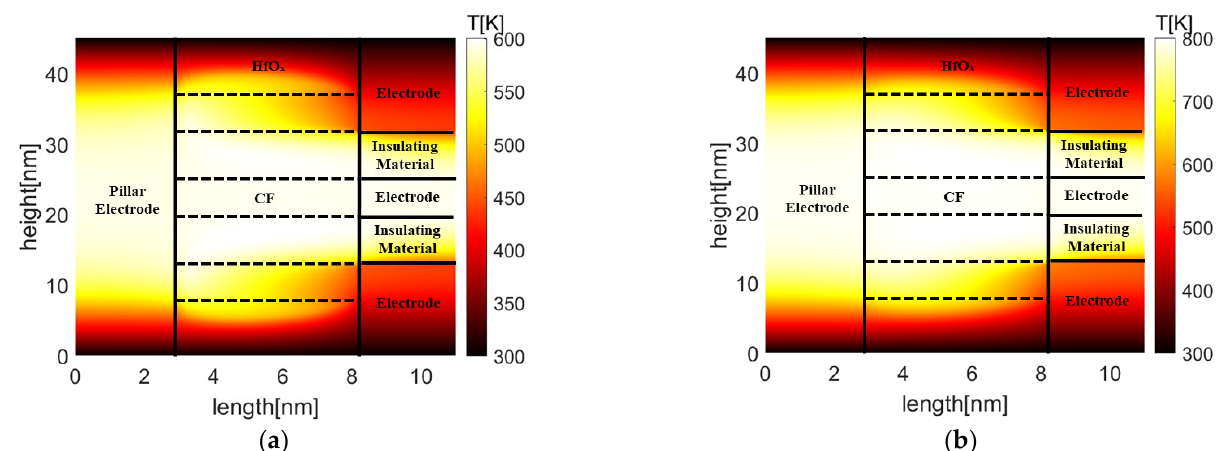
Figure 12. Temperature distributions in Pt-RRAM arrays with the spacing of 7 nm ( a ) TiO x ( b ) HfO x .